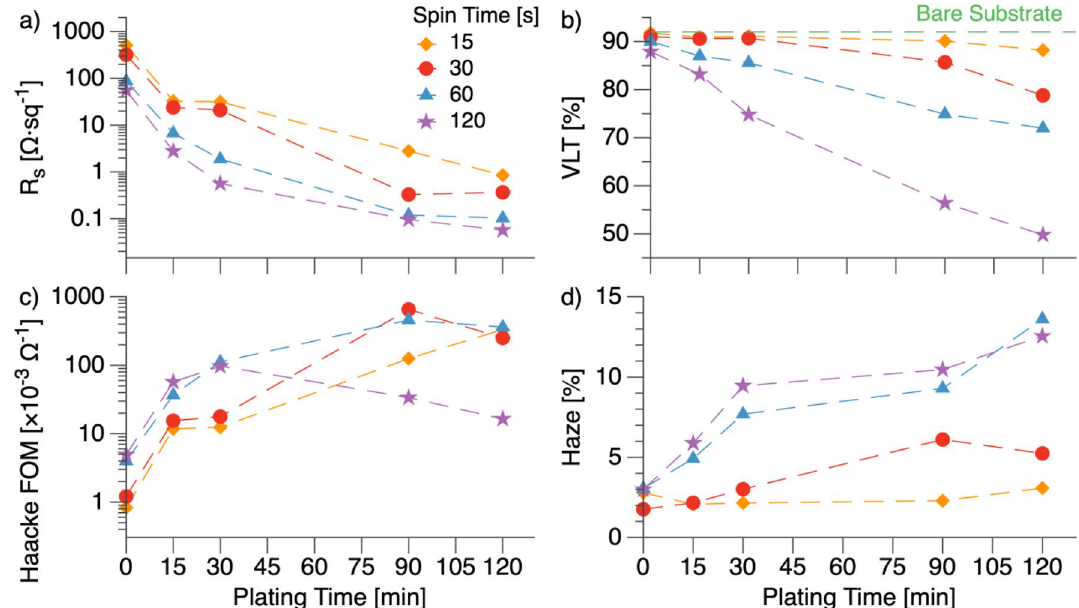
Figure 3. Electrospinning and electroless deposition parameter space investigation. ( a ) Sheet resistance (R s ) versus copper plating time. ( b ) Visible Light Transmittance (VLT) versus copper plating time. The dashed green line represents the transmittance of the bare glass substrate. ( c ) Haacke figure of merit (FOM) versus copper plating time. ( d ) Optical haze versus plating